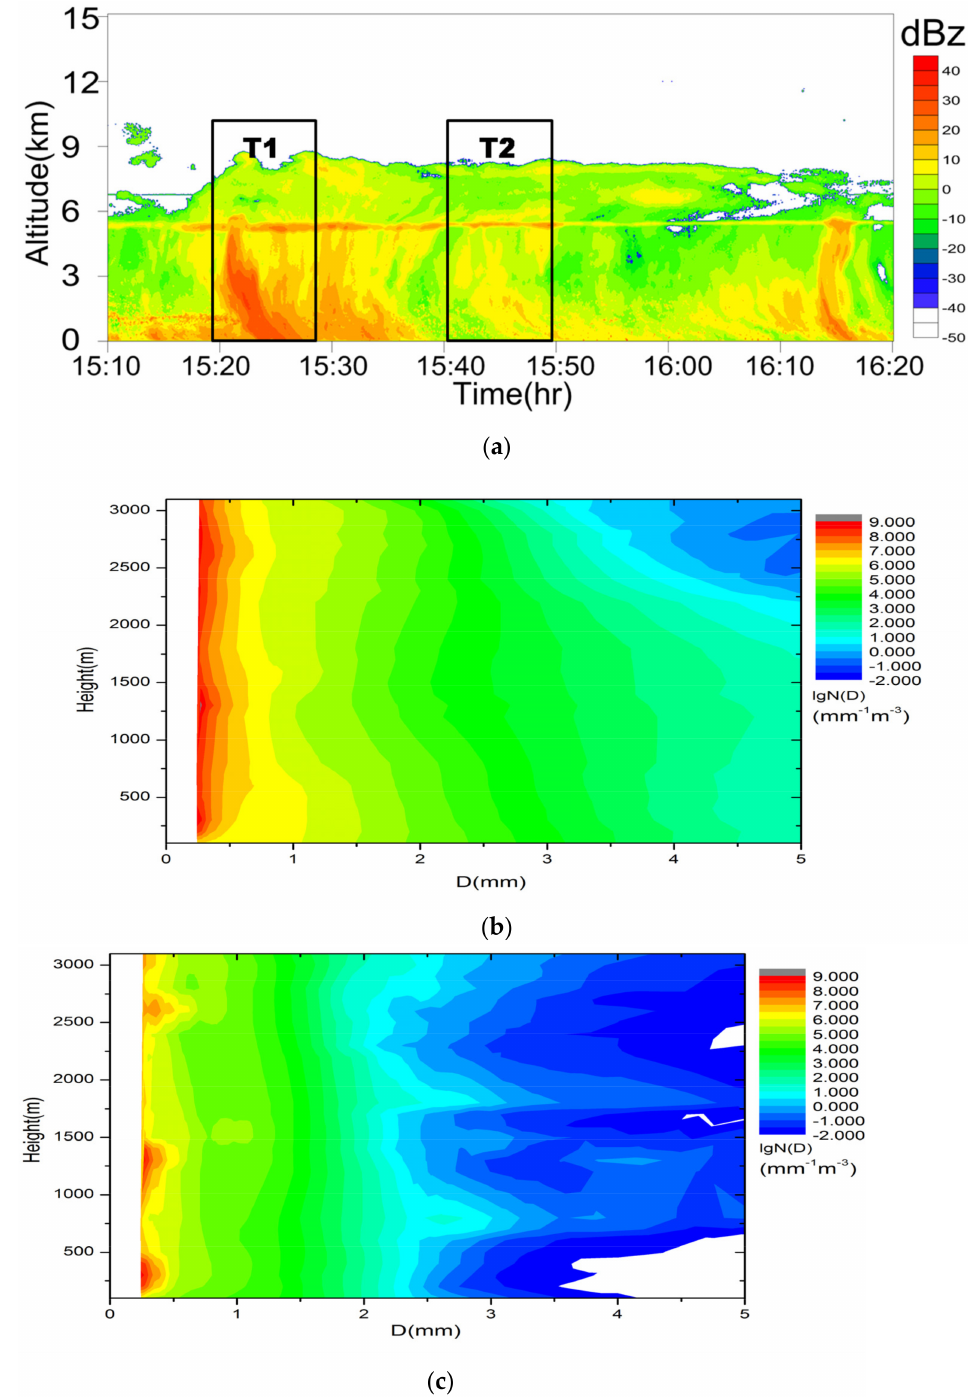
Figure 9. Comparison of vertical distribution of average DSDs between embedded convection and stratiform cloud. ( a ) The CVS on 11 July; ( b ) the vertical distribution of the DSDs in the T1 time period in ( a ); ( c ) vertical distribution of the DSDs in the T2 time period in ( a